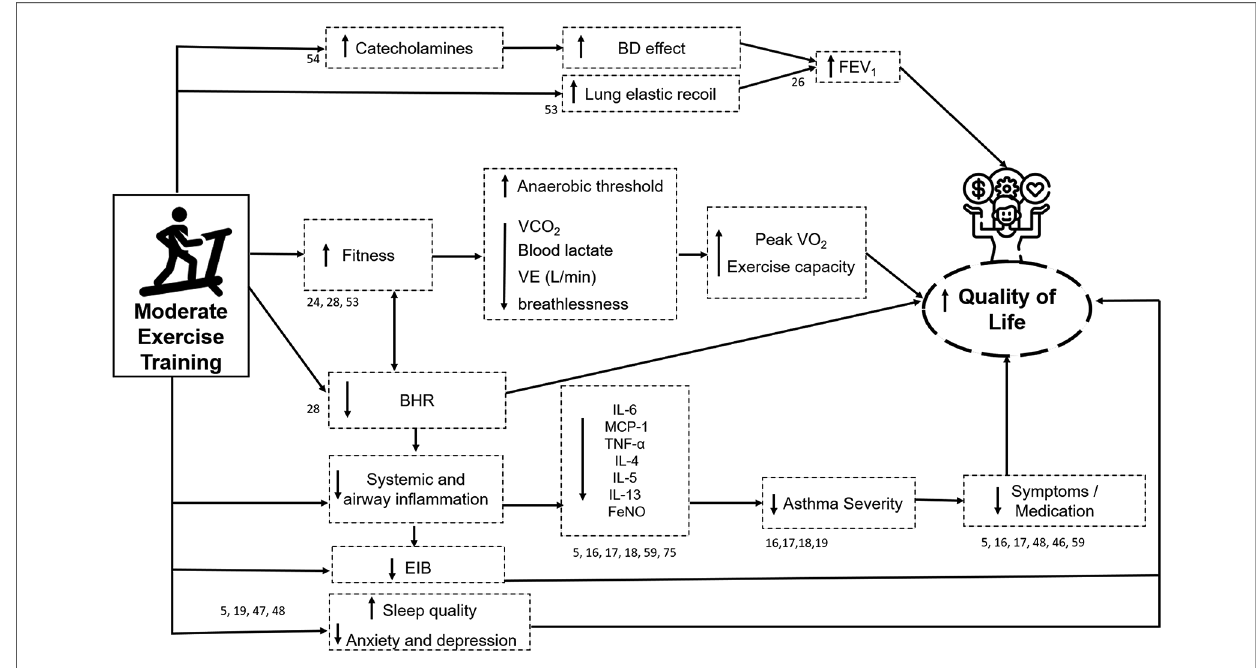
FIGURE 2 Illustrative fi gure of the effects of moderate exercise training in individuals with asthma. The numbers near the arrows and boxes represent the reference numbers that has demonstrated each effect. BD: Bronchodilator; FEV 1 : Forced expiratory volume in the fi rst second; VCO 2 : Carbon dioxide production; VE (L/min): Minute Ventilation (Liters per minute); Peak VO 2 : Peak oxygen consumption; BHR: Bronchial hyperresponsiveness; EIB: exercise-induced bronchoconstriction; IL: interleukins; MCP-1: monocyte chemoattractant protein-1; TNF- α : Tumor Necrosis Factor, FeNO: Fractional Exhaled Nitric Oxide; Icons made by Freepik from www. fl